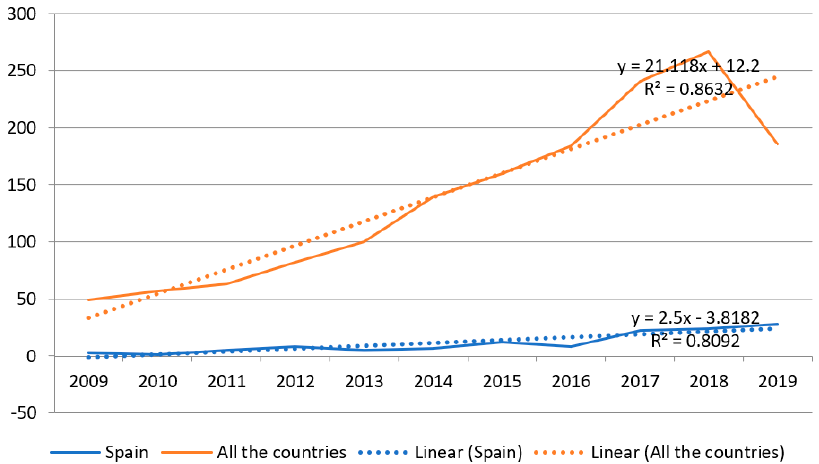
Figure 1. Scientific production on burnout in nursing based on the Web of Science (WOS) database and its trend during the years analyzed.